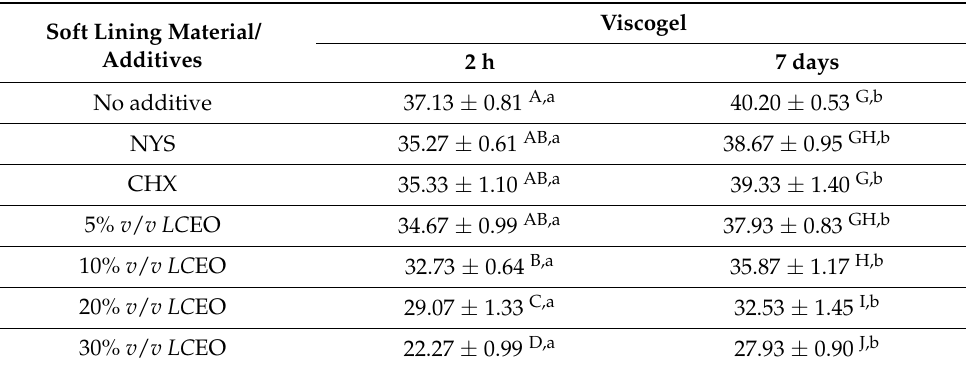
Table 7. Shore AO hardness values of Viscogel with and without additives are shown as mean ± SD ( n = 5). Same uppercase superscript letters denote no significant difference ( p > 0.05) among additives only within the same column. Same lowercase superscript letters denote no significant difference between 2 h and 7 days ( p > 0.05).